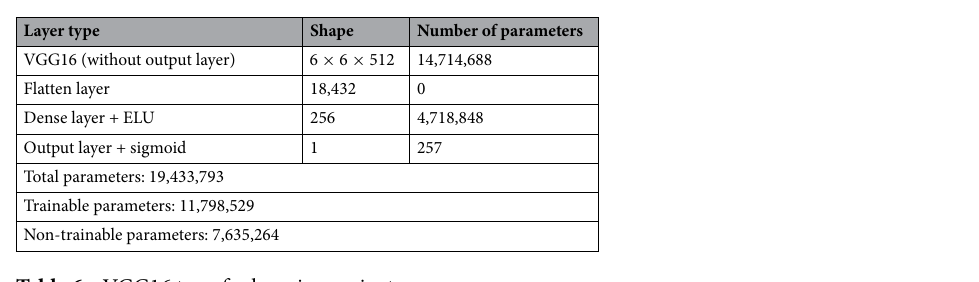
Table 6. VGG16 transfer learning